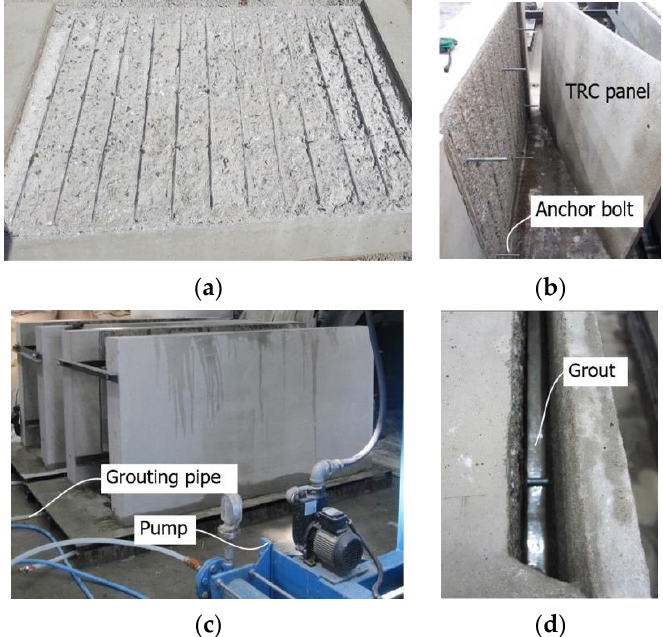
Figure 7. Fabrication of SP and SSP series specimens: ( a ) concrete surface chipping; ( b ) TRC panel assembling; ( c ) grouting pumping; ( d ) grouting.